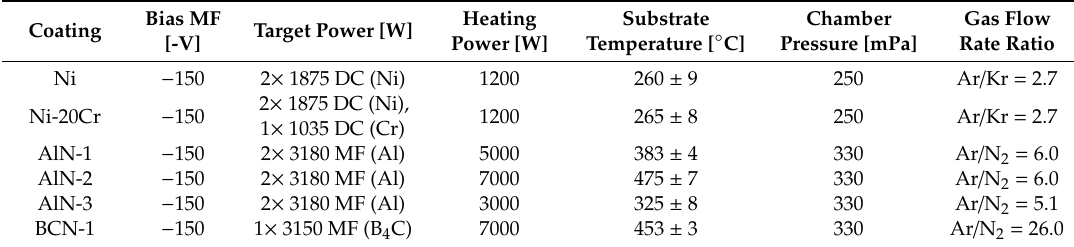
Table 1. Deposition parameters of the Ni, Ni-20Cr, AlN and BCN thin films.